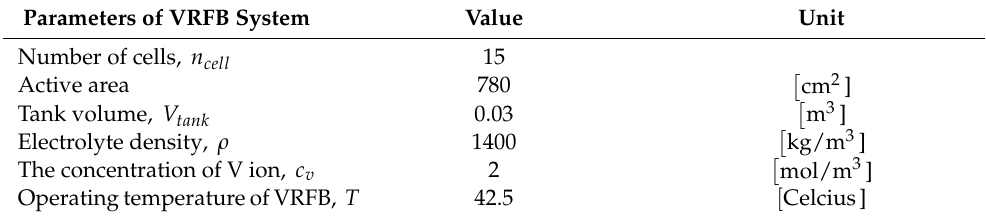
Table 3. Parameters of VRFB system.